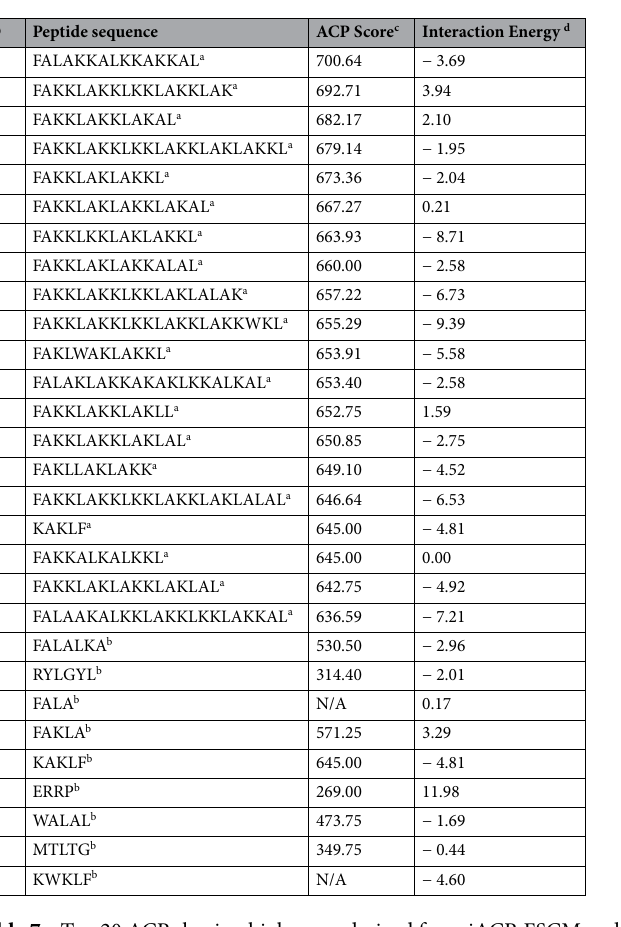
Table 7. Top 20 ACPs having high score derived from iACP-FSCM and top 9 ACPs having maximum docking scores derived from the work 53 along with their ACP scores and interaction energies. a The peptide sequences are the top 20 ACPs having high score derived from iACP-FSCM derived from this study. b The peptide sequences are the top 9 ACPs having maximum docking interactions scores derived from the work 53 . c ACP scores are calculated using the scoring function S(P) and N/A means that the peptide is not found in the benchmark dataset. d Interaction Energy is Interaction Energy Yasara Nova Force Field (kcal/mol).